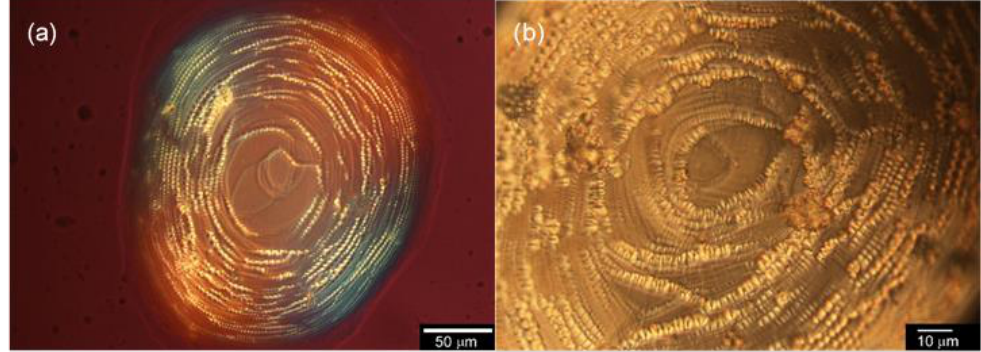
Figure 3. Polarizing optical microscopy (POM) images of P-1100-F at 99 ◦ C. ( a ) Insertion of a gypsum first-order red plate. ( b ) POM image of P-1100-F at higher magnification.